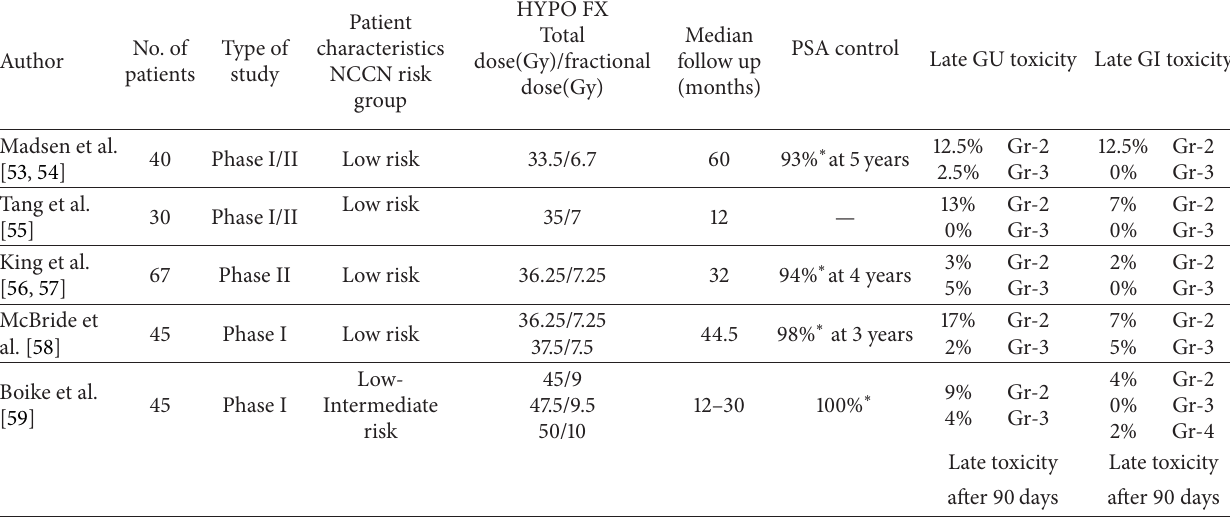
Table 2: Prospective trials of hypofractionated external-beam radiotherapy (5